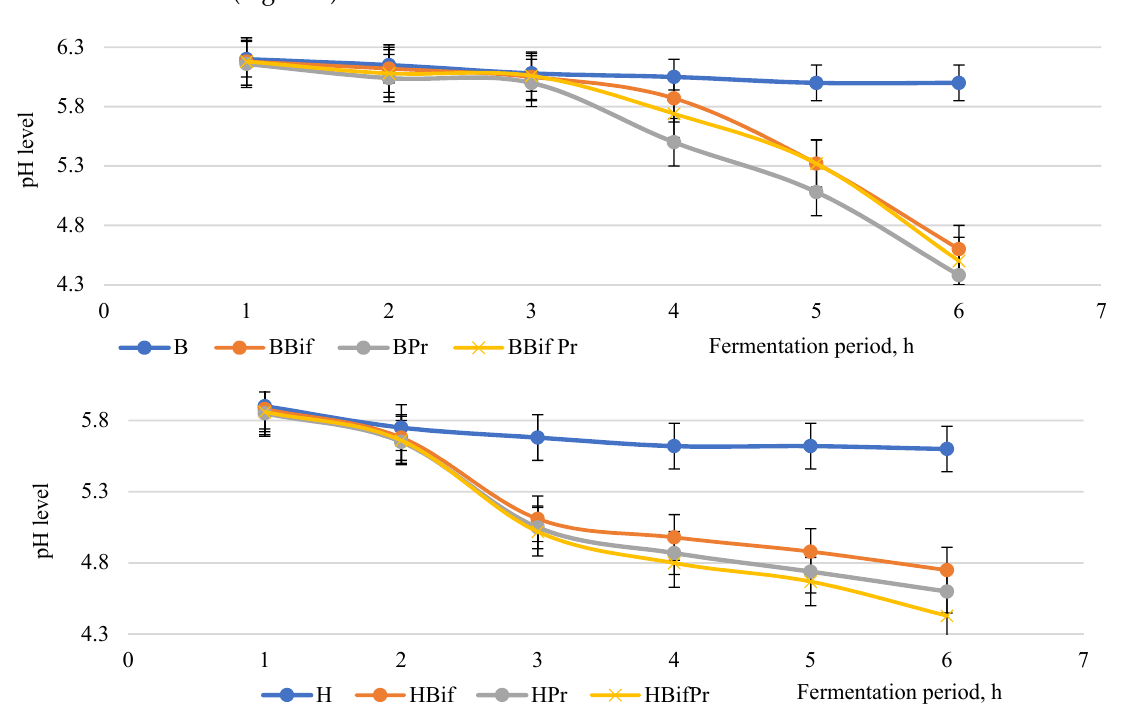
Figure 2. The pH level during the fermentation of grain-based beverages. The error bars represent the standard deviation of measurements ( n = 5). Designation of samples: B (H) unfermented barley (hemp) milk; BBif (HBif) barley (hemp) milk, fermented by Bifidobacterium longum ; BPr (HPr) barley (hemp) milk, fermented by Propionibacterium freudenreichii ; BBifPr (HBifPr) barley (hemp) milk, fermented by a combination of Bifidobacterium longum and Propionibacterium freudenreichi.